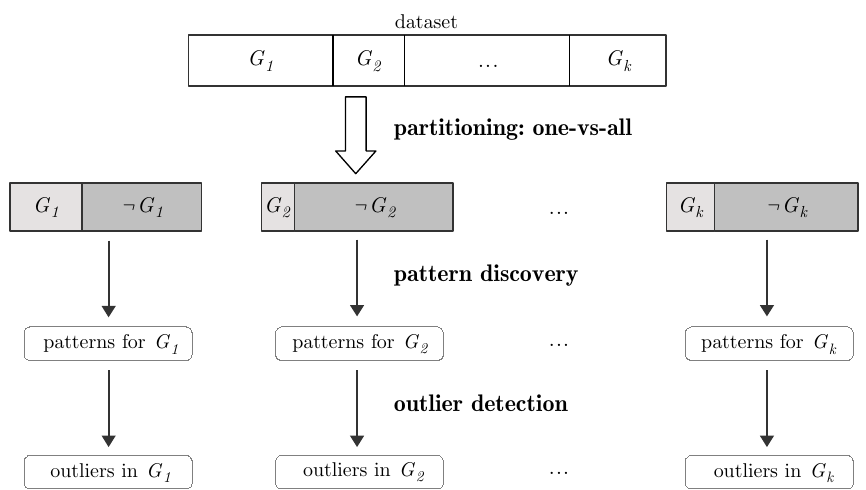
Figure 2. Overview of the method. The input is a corpus of songs that is partitioned into groups G 1 , . . . , G k , and the output is the union of the outlier songs found in each